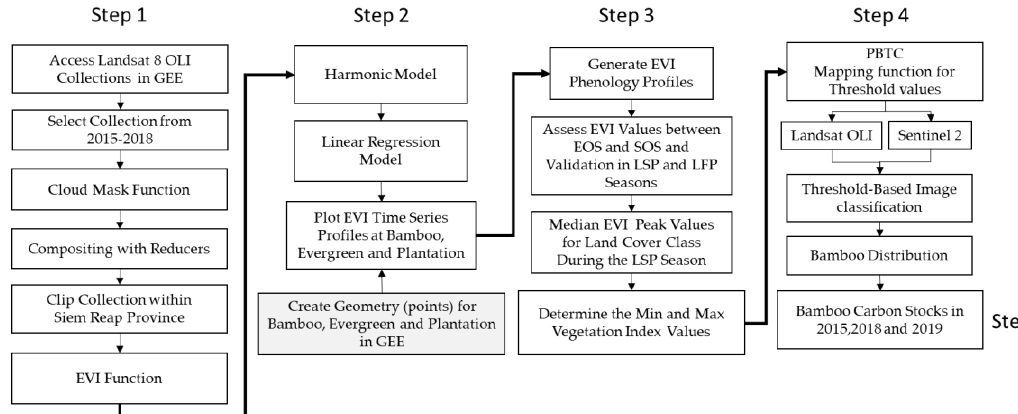
Figure 2. Methodological framework of phenology-based threshold classification to identify the natural distribution of bamboo forest. GEE, Google Earth Engine; EVI, enhanced vegetation index; EOS, end of season; SOS, start of season; LSP, leaf-shedding phenology stage; LFP, leaf-flushing phenology stage.